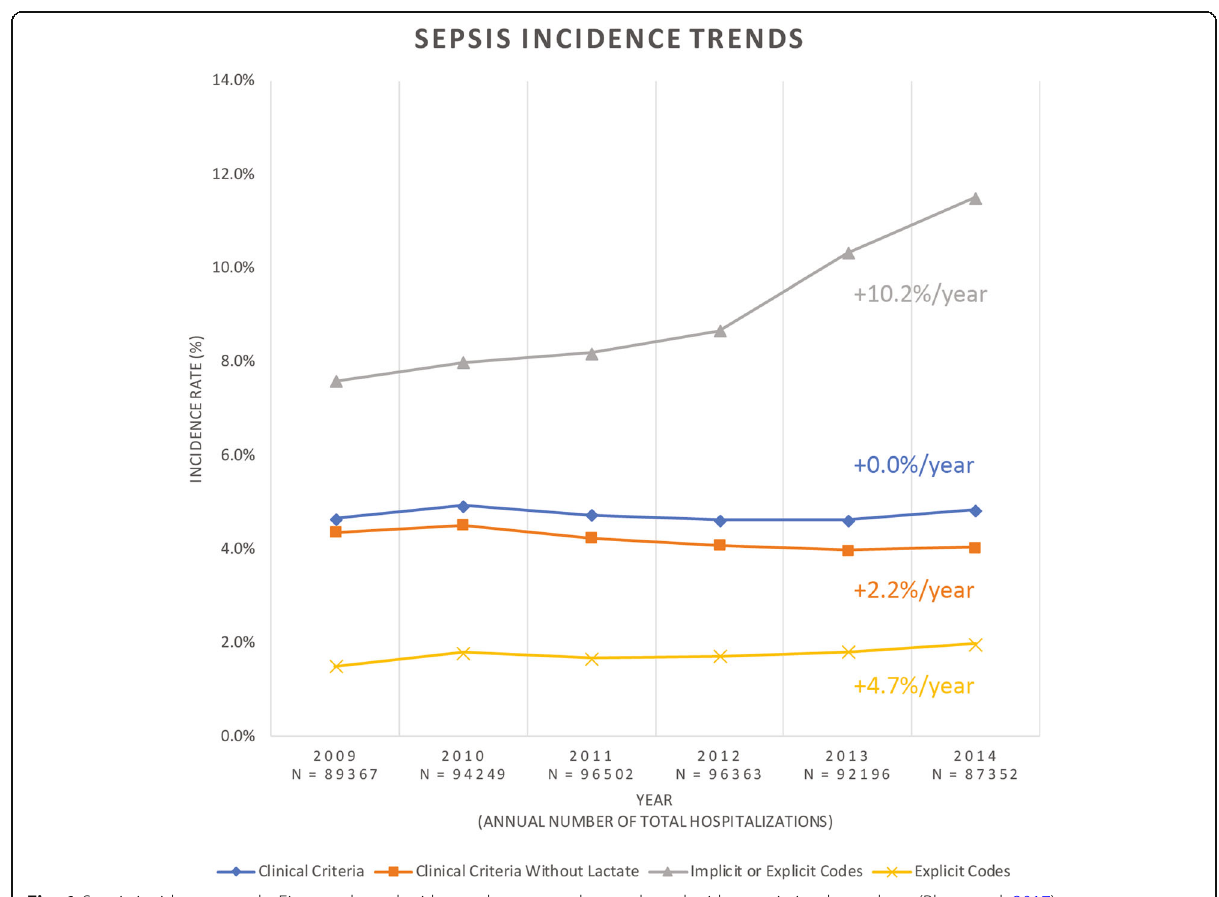
Fig. 1 Sepsis incidence trends. Figure adapted with supplementary data and used with permission by authors (Rhee et al.